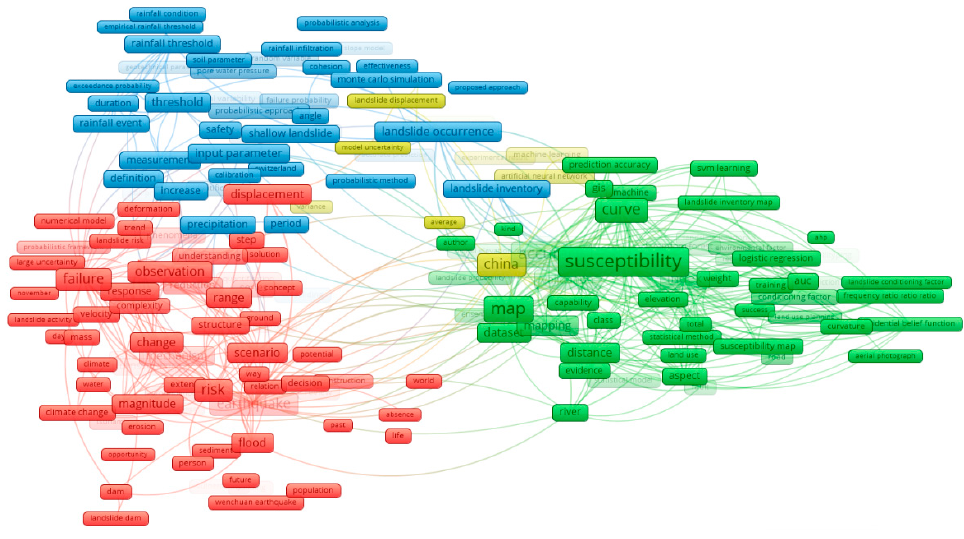
Figure 9. High-frequency keyword co-occurrence